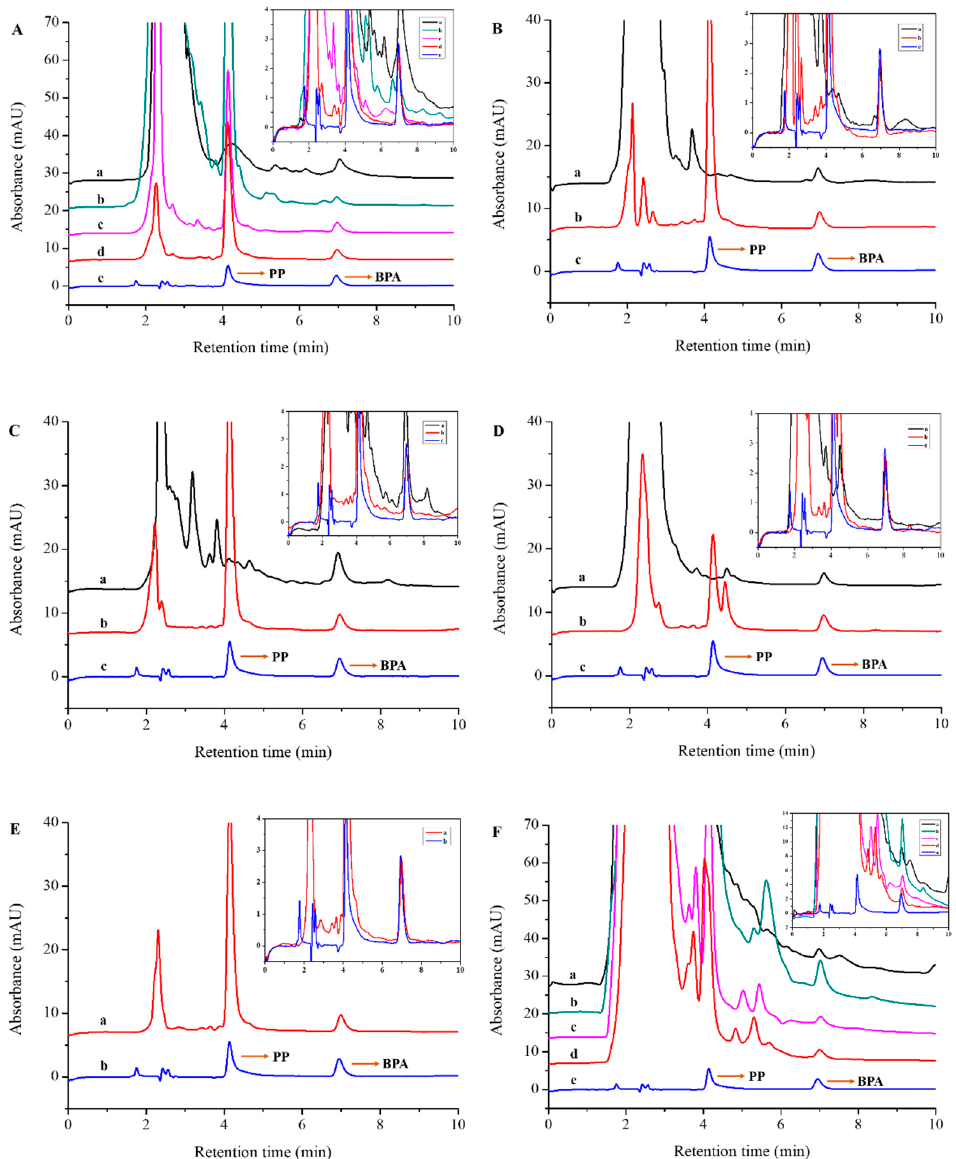
Figure 4. Chromatograms of the six investigated samples and standards. ( A ) Urine sample without PPMIP-SPE (a), urine samples after PPMIP-SPE at loading pHs of 3.0 (b), 6.0 (c), and 9.0 (d); ( B ) bovine serum sample without PPMIP-SPE (a), bovine serum sample after PPMIP-SPE ( b ); ( C ) sediment sample without PPMIP-SPE (a), sediment sample after PPMIP-SPE (b); ( D ) milk sample without PPMIP-SPE (a), milk sample after PPMIP-SPE (b); ( E ) edible oil sample after PPMIP-SPE (a); ( F ) soybean sauce sample without PPMIP-SPE (a), soybean sauce samples after PPMIP-SPE at loading pH of 3.0 (b), 6.0 (c), and 9.0 (d); (Ae, Bc, Cc, Dc, Eb, Fe) standard mixture of PP and BPA (at the bottom of each figure); insets: enlarged chromatograms displayed in an overlapping manner. All tested samples were spiked with 500 ng of BPA, and the concentrations of both PP and BPA in the standard mixture were 500 ng · mL − 1